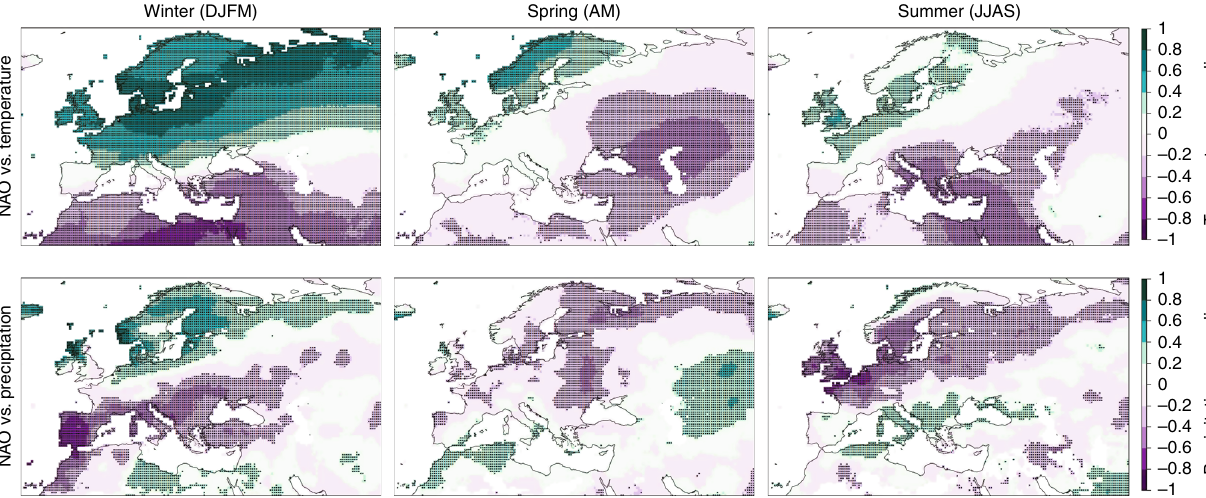
Fig. 4 NAO and related weather patterns in temperature and precipitation. Correlation between NAO and temperature anomalies ( fi rst row), and between NAO and precipitation anomalies (second row) for the seasons winter, spring, summer (columns from left to right). Regions with signi fi cant correlations are denoted by black dots. Monthly precipitation and temperature have been obtained from the CRU database (version TS4.00). We aggregated these time series into seasonal time-series and the NAO indices according to our experiment design: winter (December – January – February – March, DJFM), spring (April – May, AM), and summer (June – July – August – September, JJAS). The period between 1950 and 2015 was considered for the correlation analysis. Figure created using ggplot2 package for R